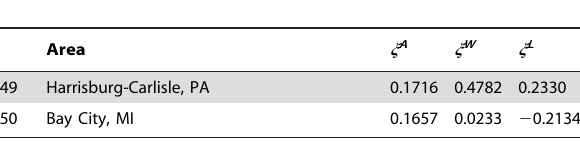
Table 2. Top 50 metropolitan areas, ranked by their scale- adjusted TFP ( j A ).